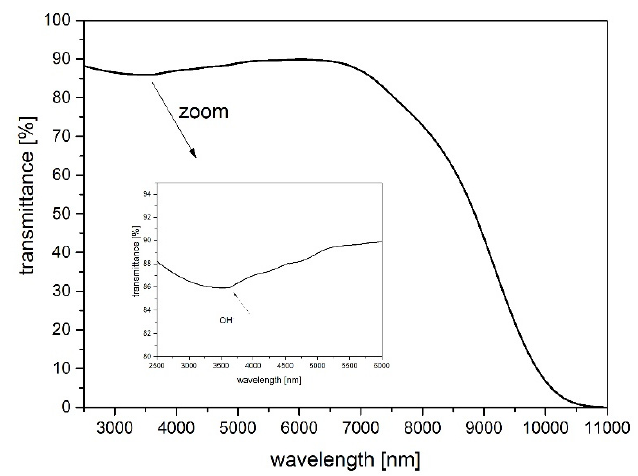
Figure 1. Transmittance spectrum of synthesized fluoroindate host glass in the mid-infrared range (thickness of the sample—2 mm).